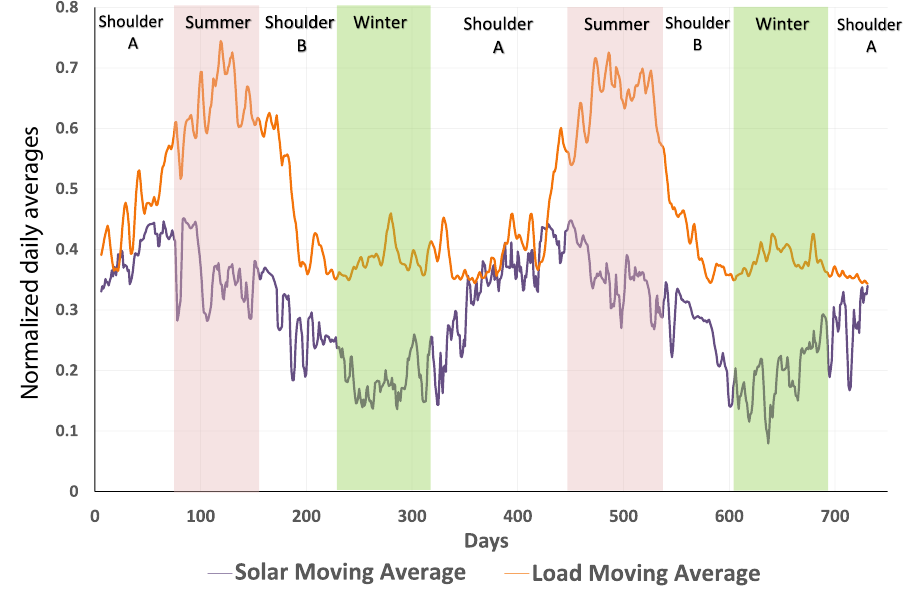
Figure 1. Seasonal classification of two years of historical data. Table 1. Seasonal